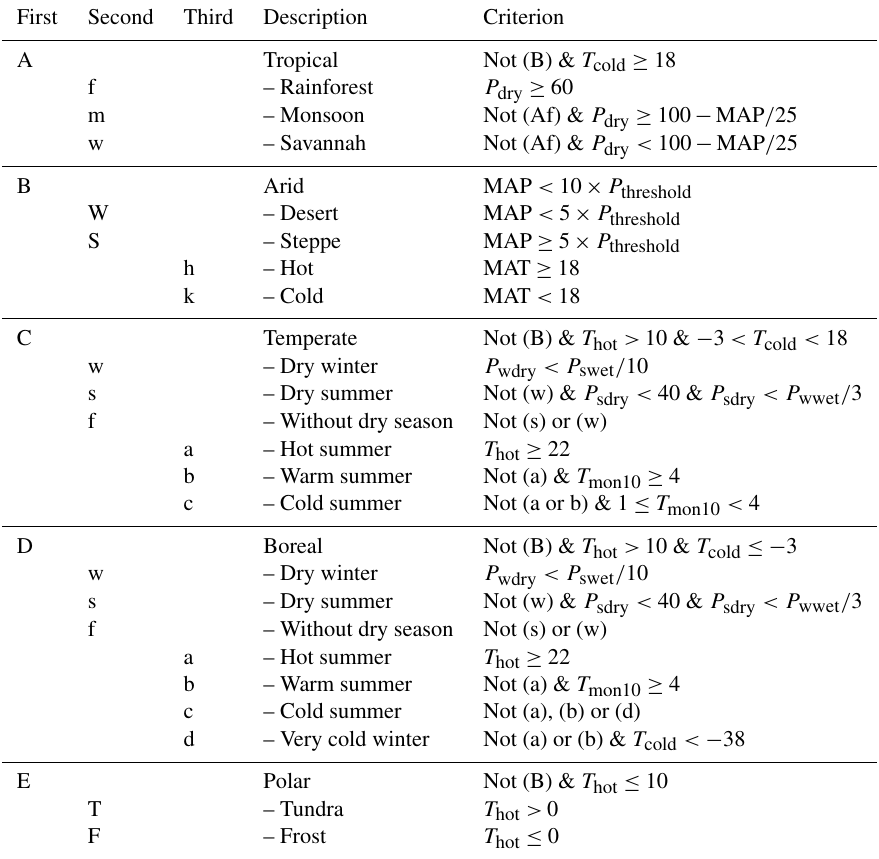
Table 2. Criteria of the Köppen–Geiger climate classification with temperature in degrees Celsius and precipitation in millimeters. First Second Third Description